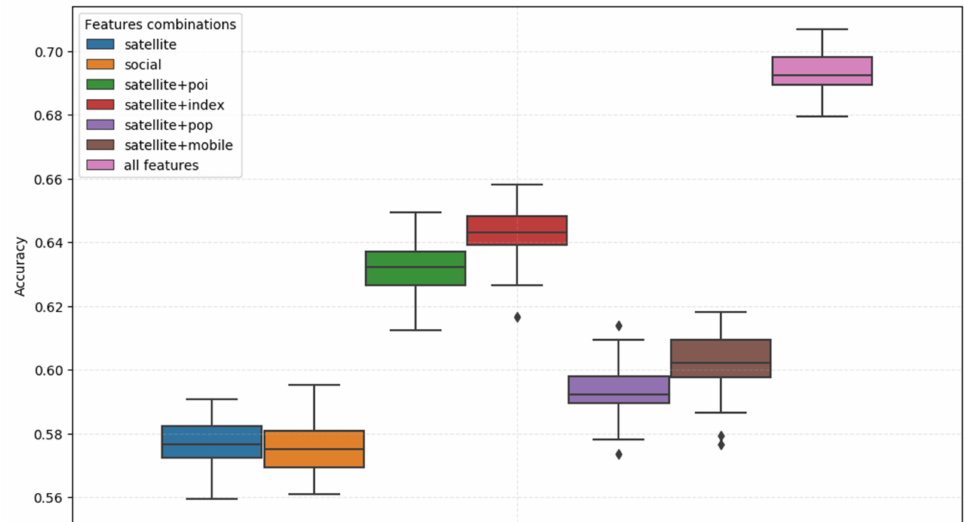
Figure 17. Accuracy of different feature combinations for Level I (run 1000 times, 6000 training, and 699 testing samples).